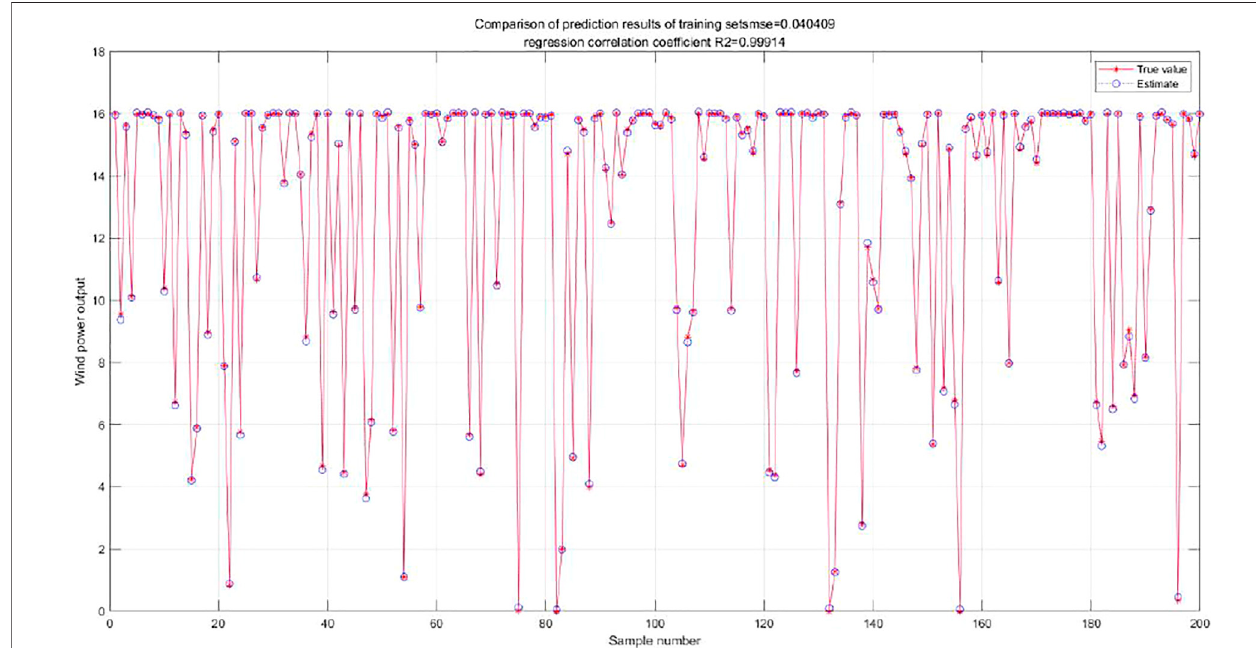
FIGURE 6 | Comparison of BP neural network training.